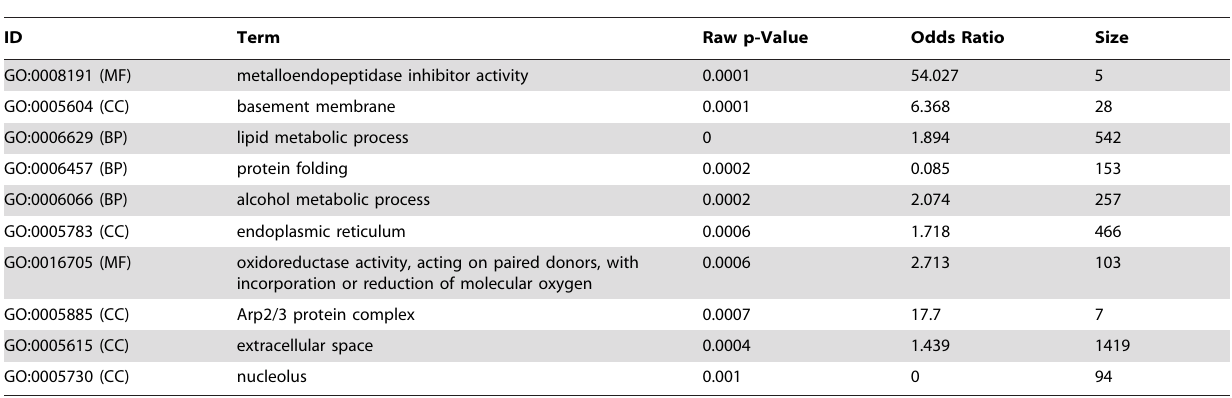
Table 2. GO enrichment analyses for the 3 mg/kg group.